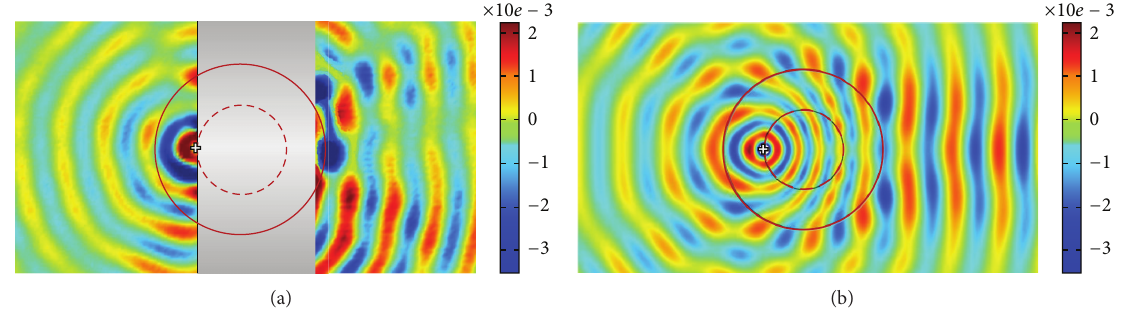
Figure 6: Electric field distributions for a point source embedded within the fabricated lens at the frequency of 10.5GHz, which is indicated by the cross. (a) Measured. (b)